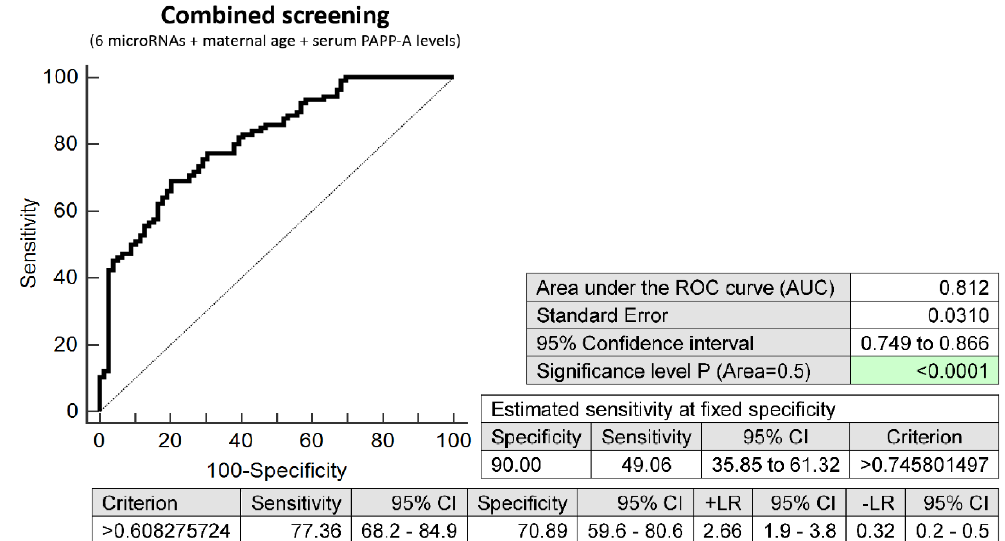
Figure 4. ROC analysis—combination of 6 microRNA biomarkers, maternal age at sampling and serum PAPP-A levels (IU/L) in early prediction of preterm delivery. The combination of 6 microRNAs (miR-16-5p, miR-21-5p, miR-24-3p, miR-133a-3p, miR-155-5p, and miR-210-3p), maternal age at sampling and serum PAPP-A levels (IU/L) was able to predict at 10.0% FPR the occurrence of preterm delivery in 49.06% pregnancies.